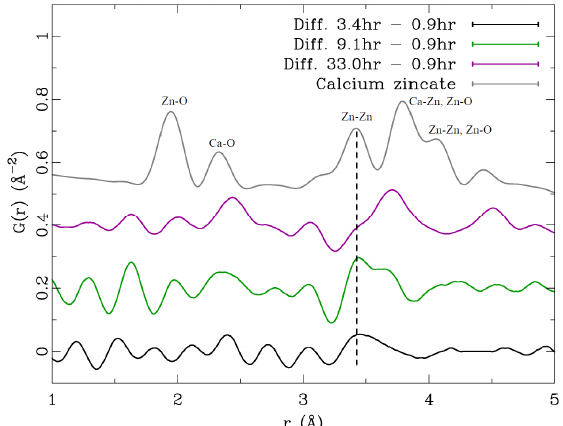
Figure 3. In situ X ‐ ray pair distribution function difference curves of alkali ‐ activated slag (AAS) with 0.5 wt. % nano ‐ ZnO (relative to amount of slag) as a function of reaction time. Each difference curve was obtained by subtracting the initial curve (0.9 hr) from the curve at the designed time (e.g., “33.0hr – 0.9hr” denotes the difference curve obtained by subtracting the 0.9 hr curve from the 33.0 hr pair distribution function). The simulated X ‐ ray pair distribution function of calcium zincate (CZ) is also provided, where the Zn ‐ Zn correlation at 3.42 Å is labeled and compared with the intensities of the difference